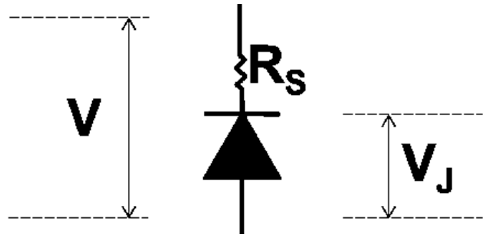
Figure 4. The equivalent circuit for a real laser diode implied by Equation (19).